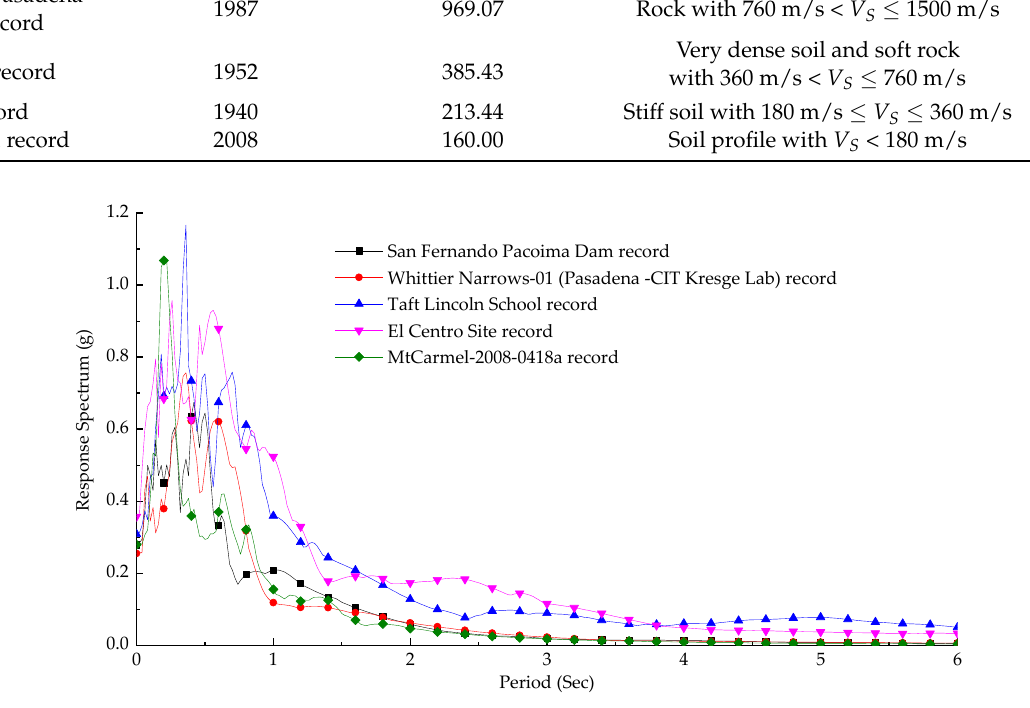
Figure 8. Spectra of the five earthquake records (N-S).